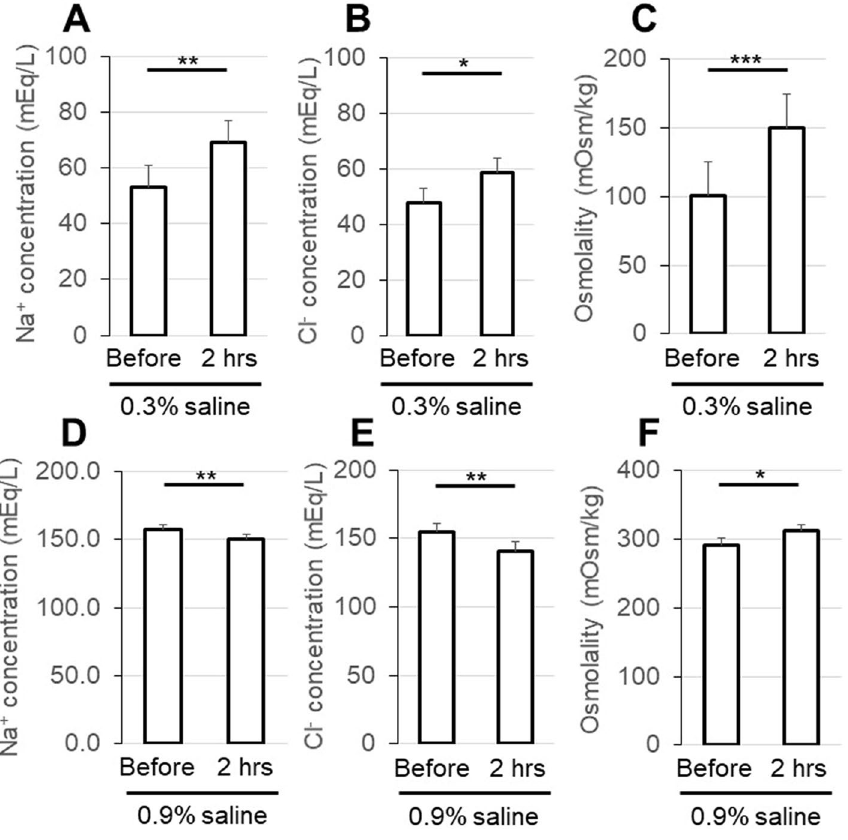
Figure 2. Comparison of electrolytes and osmolality of the injected solution before and 2 h after 0.3% ( A – C ) or 0.9% saline ( D – F ) was injected into the bladder. Bladder pressure was maintained at 30 cmH 2 O for 2 h. The Na + concentration was significantly increased when 0.3% saline was injected ( A ) but decreased when 0.9% saline was injected ( D ). The Cl − concentration was also significantly increased when 0.3% saline was injected ( B ) and decreased when 0.9% saline was injected ( E ). The osmolality showed similar changes; it significantly increased when 0.3% saline was injected ( C ) and significantly decreased when 0.9% saline was injected ( F ). Values are the mean ± SEM of measurements in 8 rats. *p < 0.05, **p < 0.01, ***p < 0.001 between values.